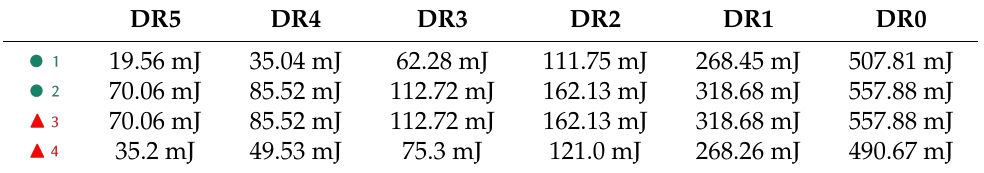
Table 9. Total energy consumed by the node in a communication phase for the different